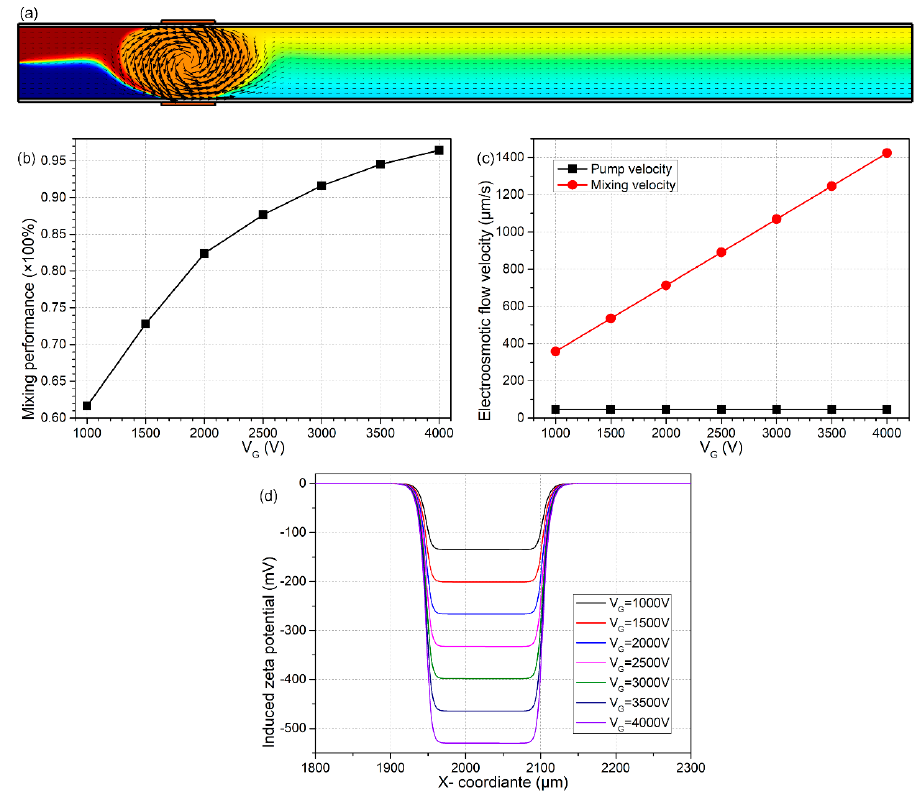
Figure 3. Effect of the magnitude of gate voltage V G on the device performance, for given values of L G = 150 μm and Vs = 30 V. ( a ) An arrow and surface plot of electroosmotic streamlines and the resulting molar concentration distribution of electroneutral chemical analyte (unit: mol/m 3 ) under V G = 2000 V of γ = 82.42%. ( b ) V G -dependent mixing performance. ( c ) Electroosmotic flow velocity in terms of pumping and mixing as a function of the magnitude of gate voltage V G . ( d ) Distribution of the non-uniform induced zeta potential along the channel sidewall adjacent to the negatively-polarized gate electrode for distinct V G , in which the negative sign implies a positive charge cloud within the Debye layer above the right-side G